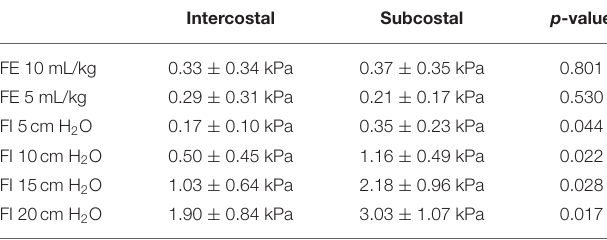
TABLE 2 | Changes in liver stiffness according to breathing